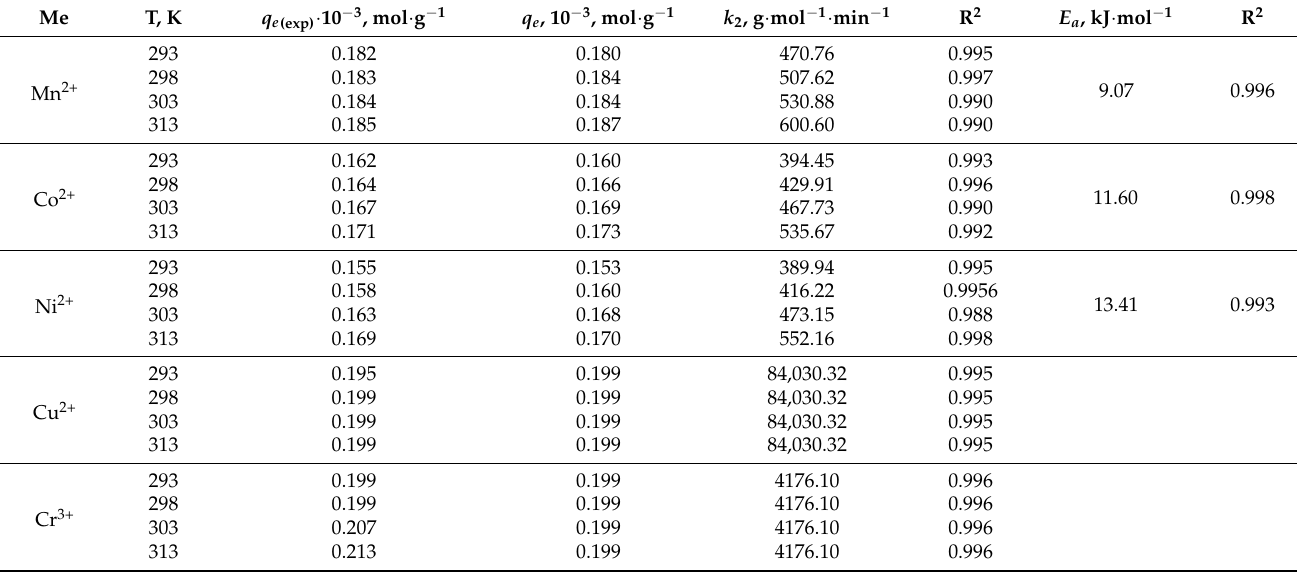
Table 2. Kinetic parameters of pseudo-second-order model for sorption of studied ions on Li-TiOP sorbent at different temperatures.